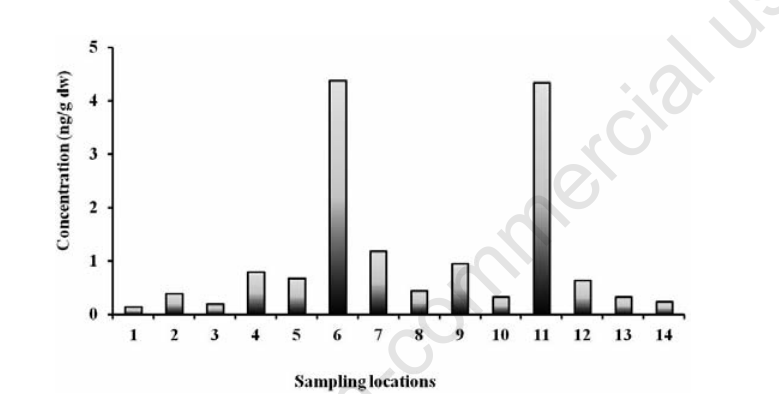
Figure 2. Average of ∑polychlorinated biphenyls in urban soil at different locations in Delhi, India.